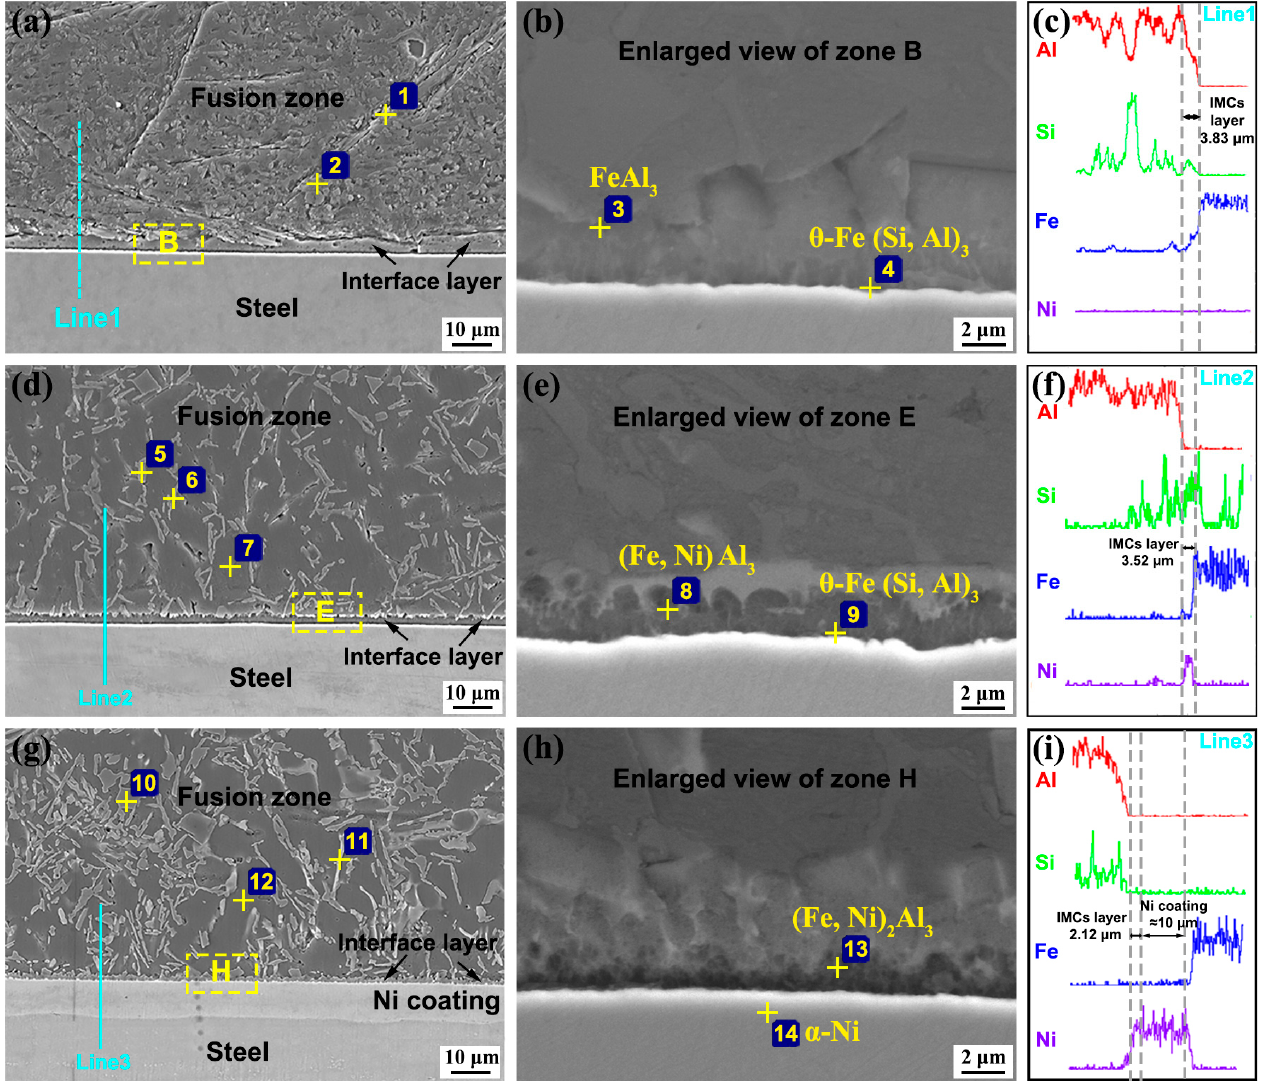
Figure 4. The microstructure and corresponding EDS line scanning results of joints: ( a–c ) without Ni coating; ( d–f ) with 5 μ m Ni coating; ( g–i ) with 10 μ m Ni coating.